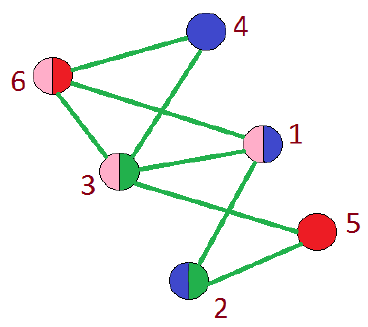
Figure A3. Representation of multiple participation of a nodes in more than one circle.